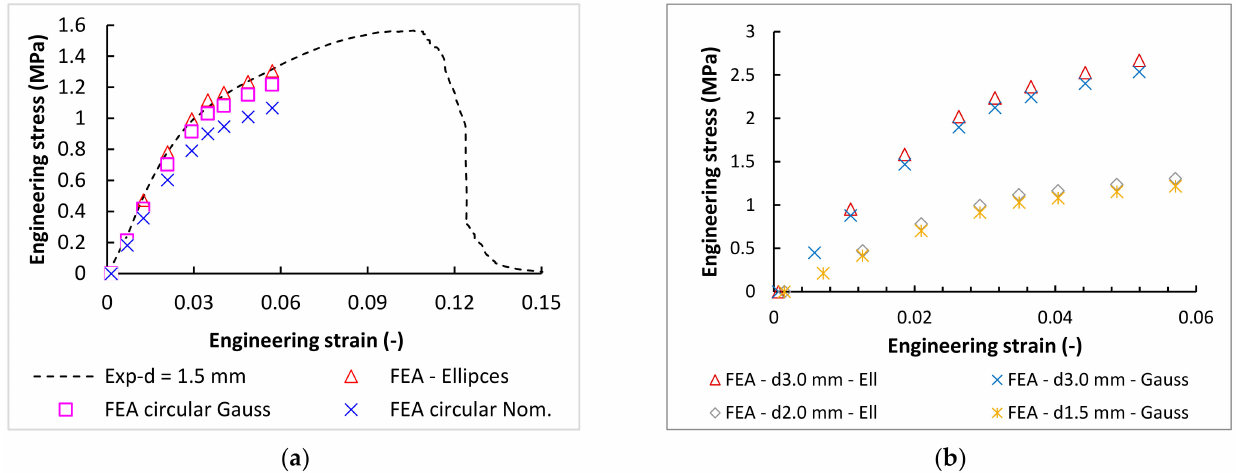
Figure 16. ( a ) The comparison of the experimental data and FEA with three types of cross-section (elliptical, circular Gauss, and circular nominal). ( b ) The comparison of the FEA results for the lattice structure dimensions of 2.0 and 3.0